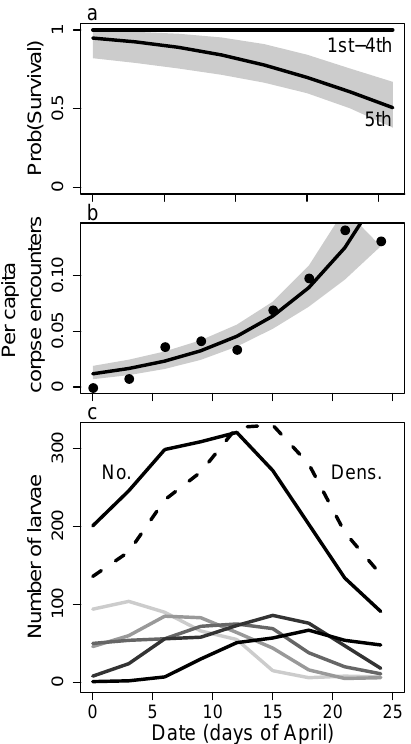
Figure 2. Change in ( a ) the mean probability of survival; ( b ) the per capita corpse encounter rate, and ( c ) the number of larvae in each stage and total caterpillar biomass for Anaea aidea over the study period. Gray shaded areas represent the 95% CI. Points in ( b ) represent the number of caterpillar corpses encountered per capita in each survey, and the line represents the encounter rate; fit using Poisson regression. Upper lines in ( c ) show the total number of caterpillars ( No. ) and the size-scaled density ( Dens. ) over time, while the lower lines show the number of caterpillars in each instar. From light to dark, these lines represent early to late